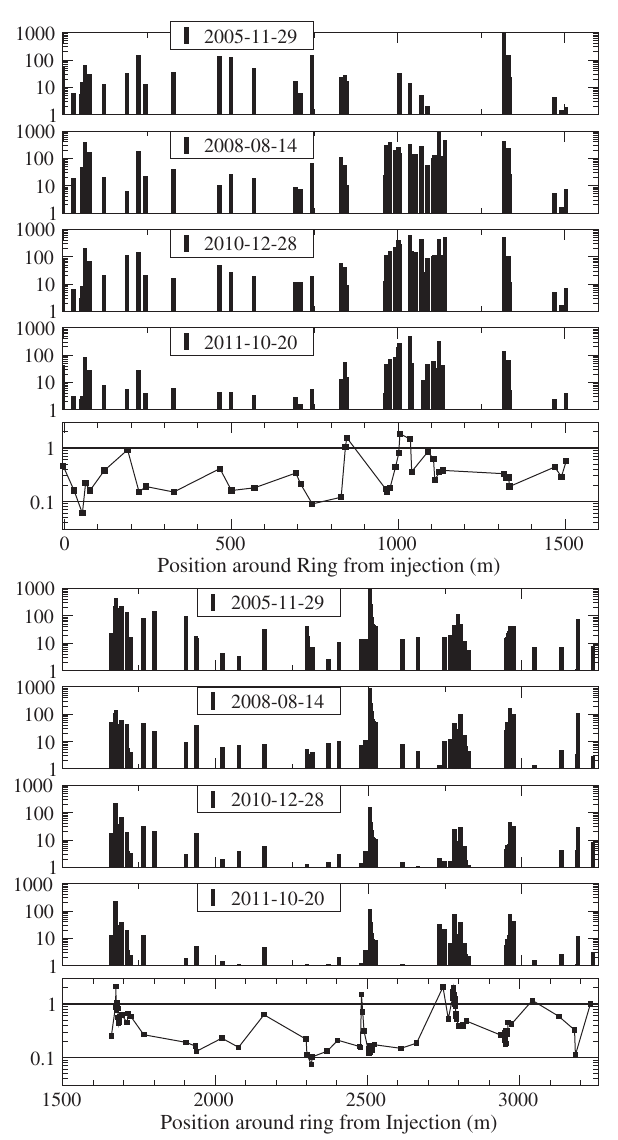
FIG. 13. Main Injector residual radiation history from injec- tion to abort region (upper) and from abort region to injection (lower) measured on contact at barcoded locations. Ratio of measured radiation (November 2011/August 2008) is shown below the measurement sets. Ratio is somewhat overstated due to less cool down time for 2008 data. Major loss points: injection (50 m), collimation (1000 m), abort (1675 m), proton extraction to Tevatron (and other transfers) (2500 m), NuMI Extraction (2780 m), antiproton extraction to Tevatron (2950